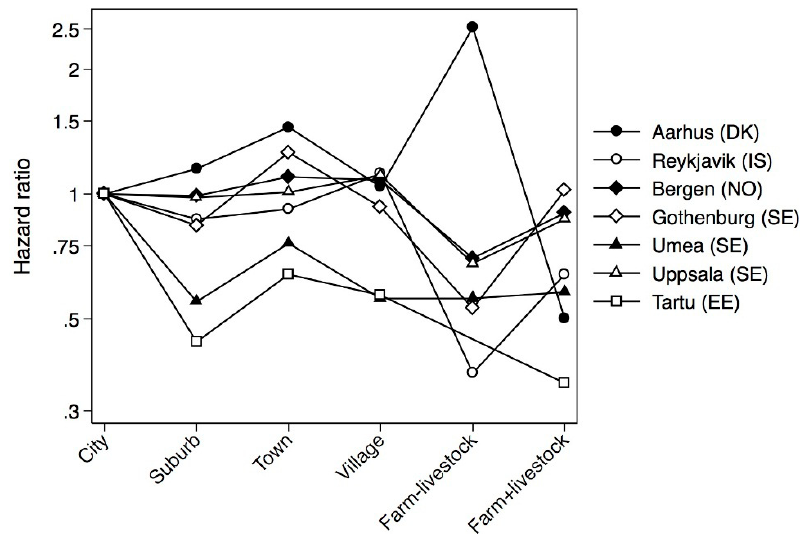
Figure 3. Centre specific Cox regression analyses on asthma presented as HR adjusted for age, sex, centre, parental asthma, smoking, body silhouette at 8 years of age and parental smoking in childhood.